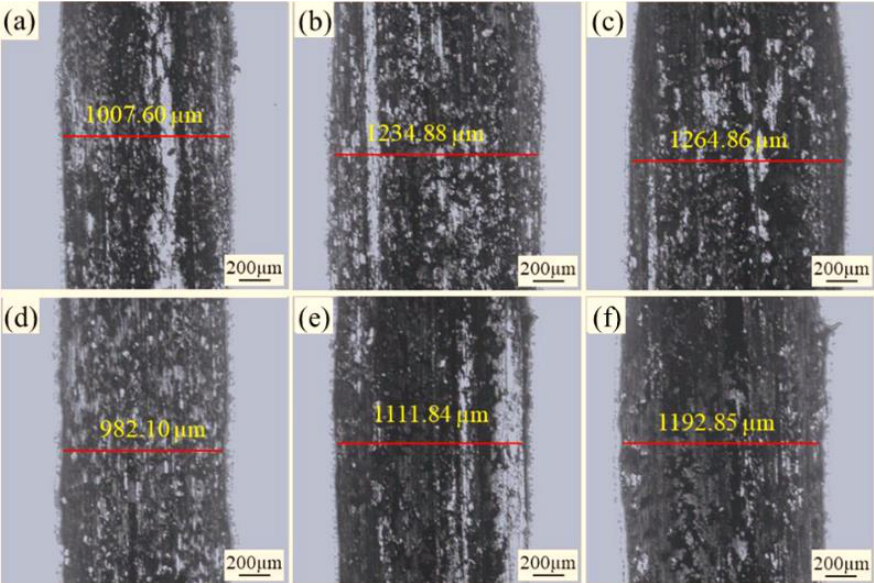
Figure 8. LSCM images of the wear scars under different loads: 20 N ( a , d ); 30 N ( b , e ); 40 N ( c , f ).